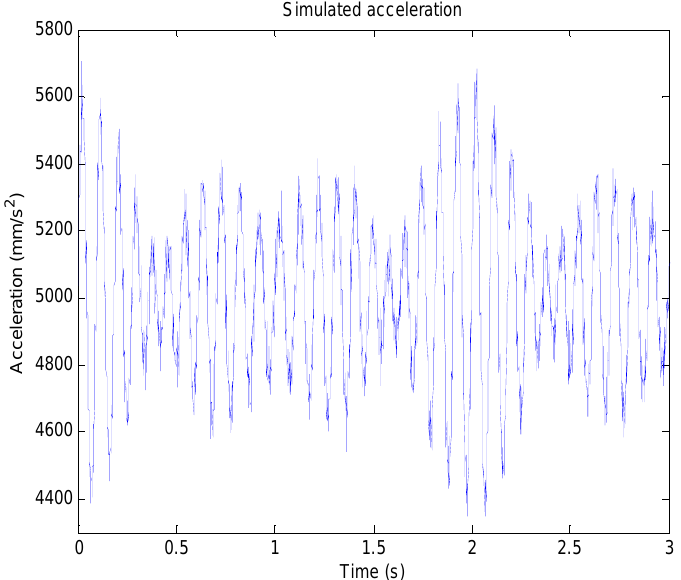
Figure 6. Simulated acceleration output consisting of the sinusoidal acceleration signals with noise and DC offset.